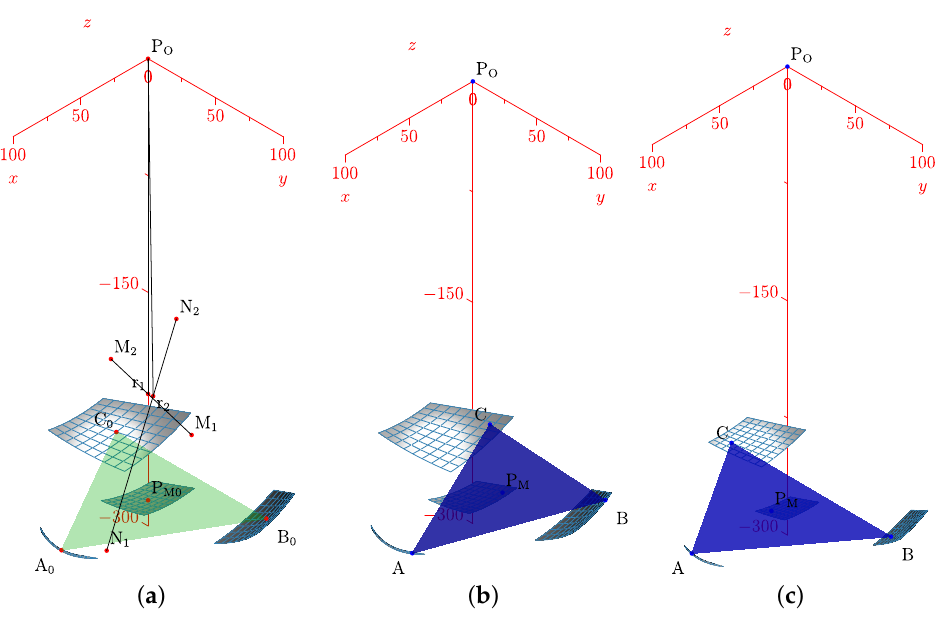
Figure 6. Forward kinematics for ( a ) initial position and ( b ) θ 1 range = θ 2 range = [ − 15 ◦ ,15 ◦ ] , θ 1 = θ 2 = 10 ◦ and ( c ) θ 1 range = θ 2 range = [ − 10 ◦ ,10 ◦ ] , θ 1 = θ 2 = 5 ◦